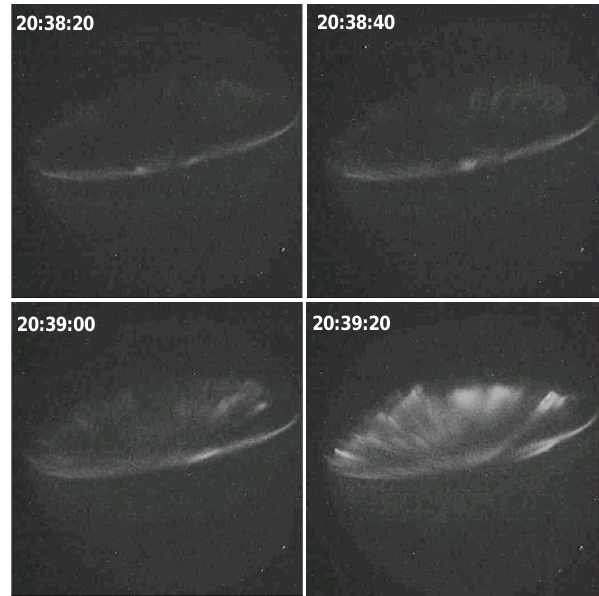
Fig. 7. Kilpisj¨arvi (KIL) ASC images of the green (5577 ˚A) line at 20:38:20, 20:38:40, 20:39:00, and 20:39:20 UT. Images have been contrast-enhanced in order to distinguish the faint auroral